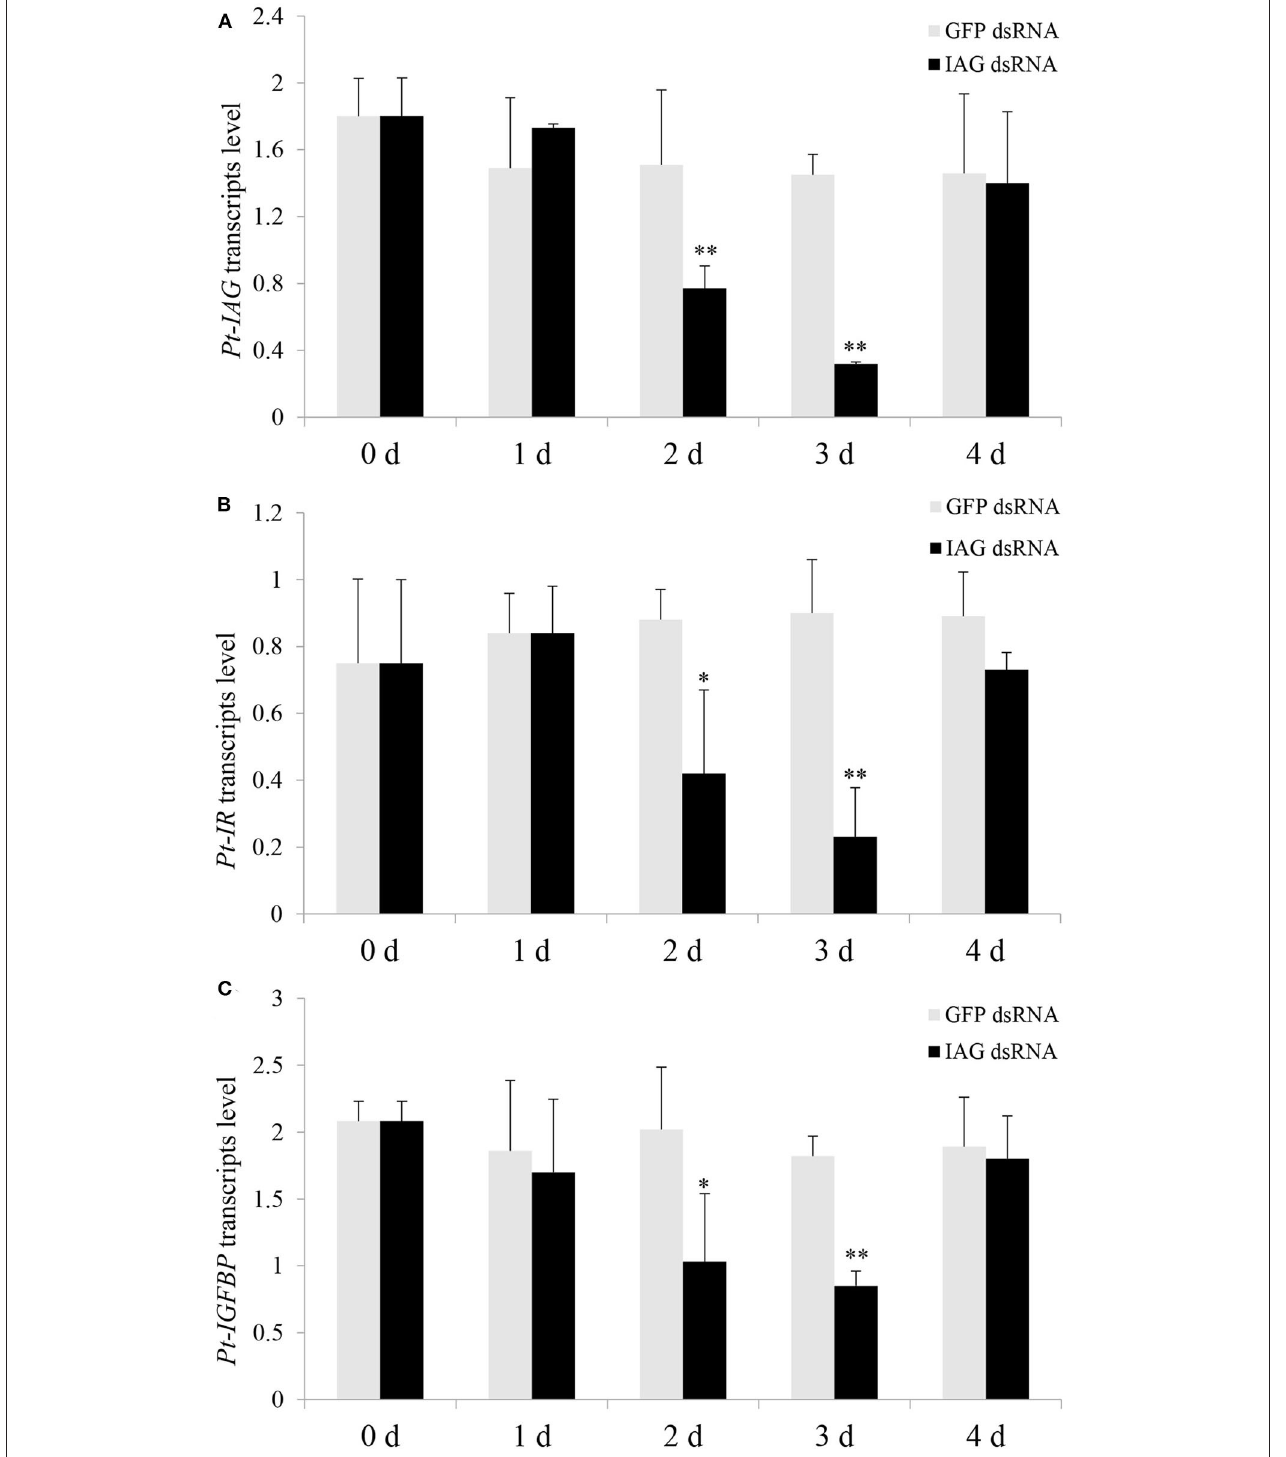
FIGURE 2 | Effects of insulin-like androgenic gland hormone (IAG) dsRNA injection on gene expression of Portunus trituberculatus ( Pt ) -IAG (A) , Pt- insulin receptor ( IR ) (B) , and Pt- insulin-like growth factor-binding protein ( IGFBP ) (C) . Bars represent mean ± SEM ( n = 5). ** P < 0.01 or * P < 0.05 values statistically different from those of the control groups (Student’s t